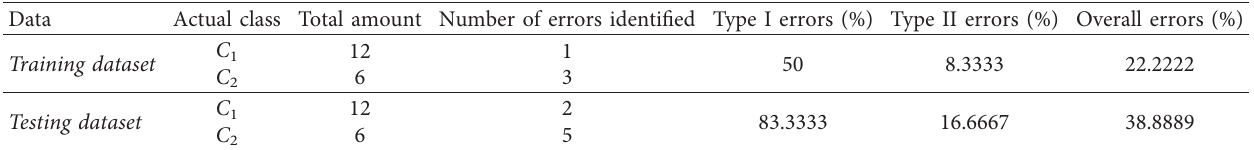
Table 9: Error summary with single logistic regression